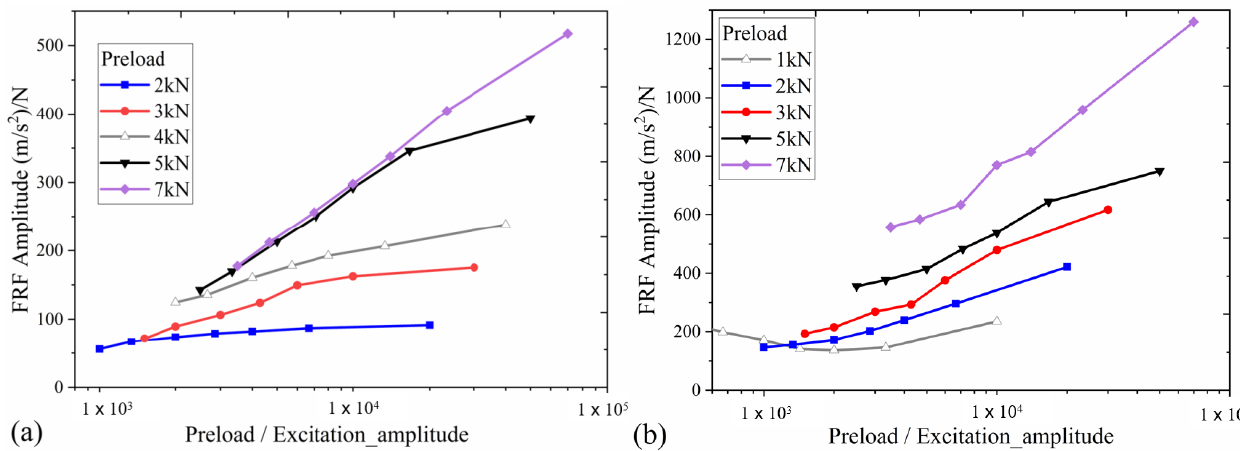
Figure 21. FRF amplitudes versus the ratio of ‘ Bolt tension/Excitation ’ , ( a ) two-beam joint, ( b ) one monolithic beam.